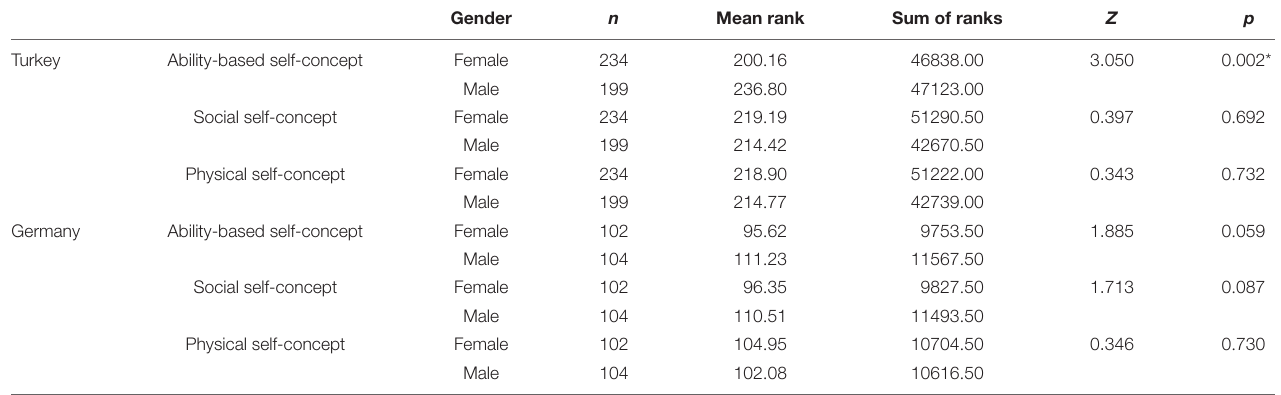
TABLE 6 | Mann–Whitney U test results of children’s scores in the dimensions of the self-concept questionnaire for children by gender. Gender n Mean rank Sum of ranks Z p Ability-based self-concept Female